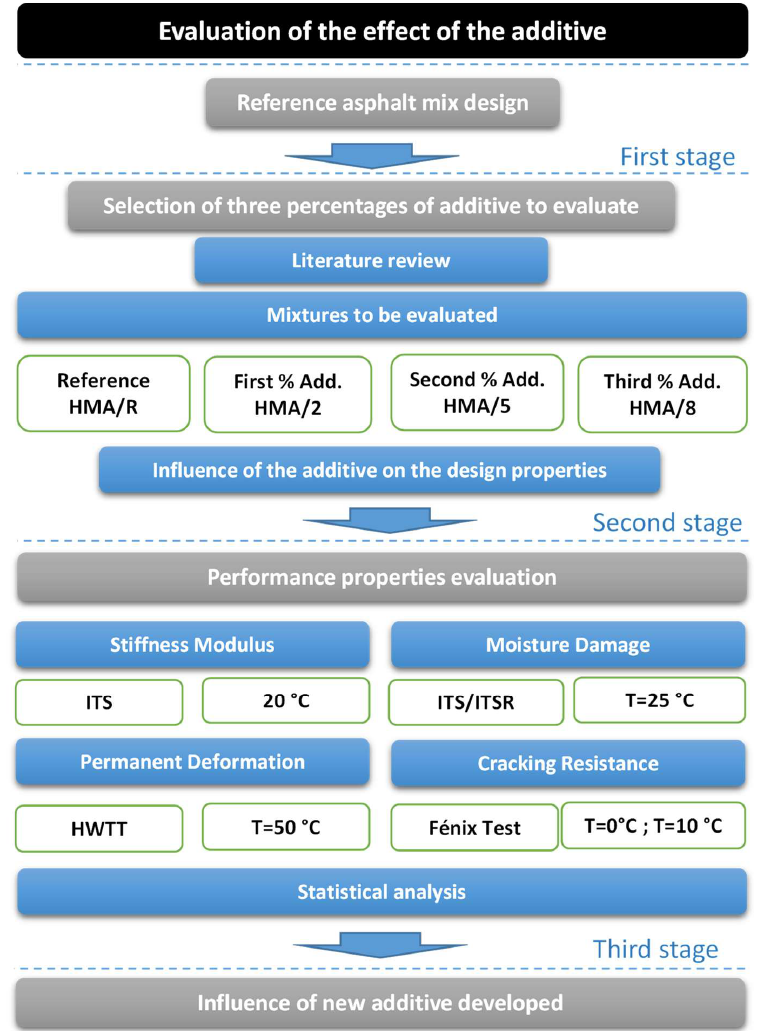
Figure 4. Experimental scheme of the study to show the effect of the new additive based on WTTF. Table 2. Properties of the asphalt binder and aggregates used in the